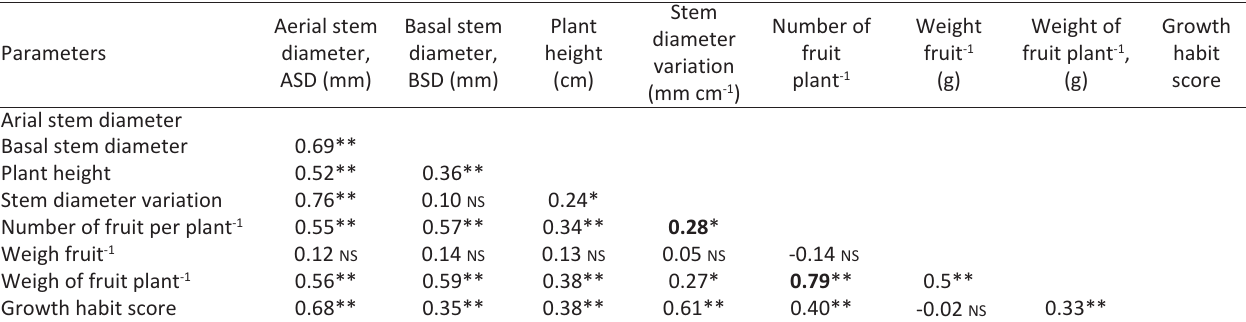
Table 3 ­ Correlation analysis showing the relationships among growth and yield parameters of improved tomato cultivars grown in